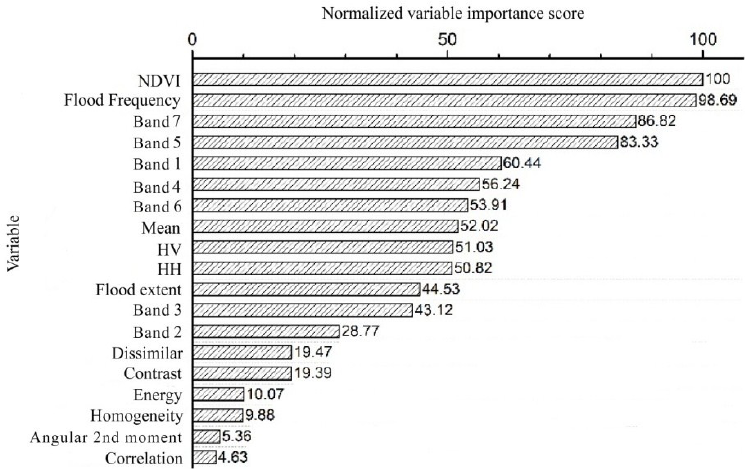
Figure 7. Normalized variable importance scores for random forest classification based on OLI + SAR + HRF model. Table 2. Error rates for classification accuracies of OLI + SAR + HRF model and OLI + SAR model. Omission Error (%)